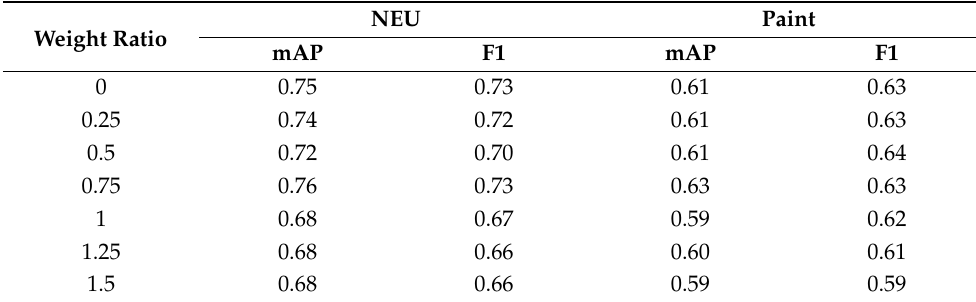
Table 4. mAP and F1-score with different weight ratios.